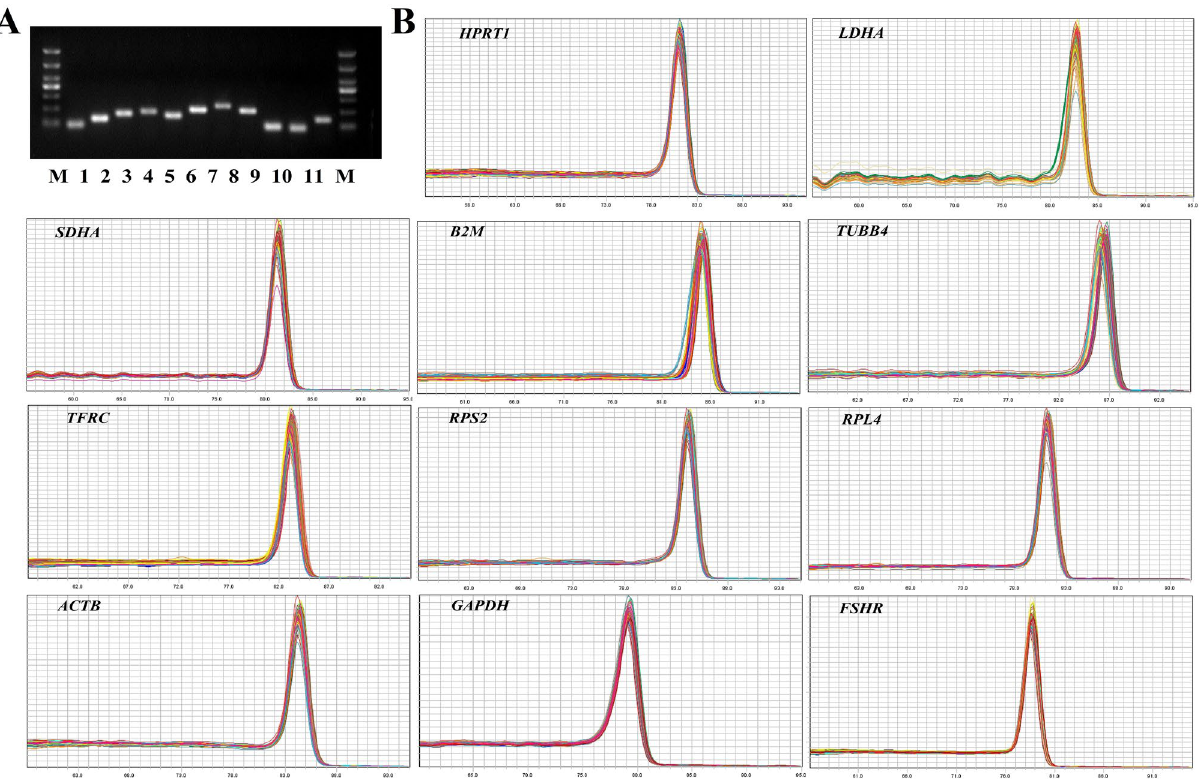
Figure 1. Primer specific detection of 10 candidate reference genes and verification gene FSHR. ( A ) PCR agarose gel electrophoresis; ( B ) Melting curves. M: DL1000 DNA marker; 1: HPRT1 ; 2: LDHA ; 3: SDHA ; 4: